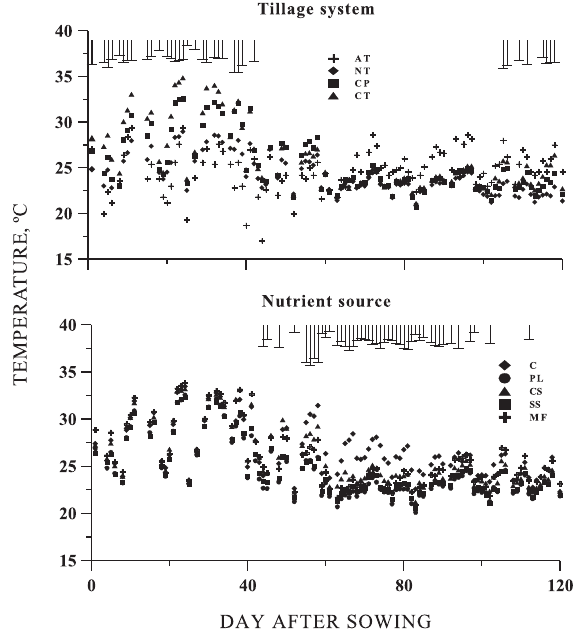
Figure 4. Air and soil temperature at 3:00 p.m., 0.05 m deep during the corn cycle in three tillage systems and five nutrient sources. (AT: air temperature; NT: no-tillage; CP: chisel plow; CT: conventional tillage; C: control; PL: poultry litter; CS: cattle slurry; SS: swine slurry; and MF: mineral fertilizer); vertical bars indicate least significant difference values (Tukey, p < 0.05).